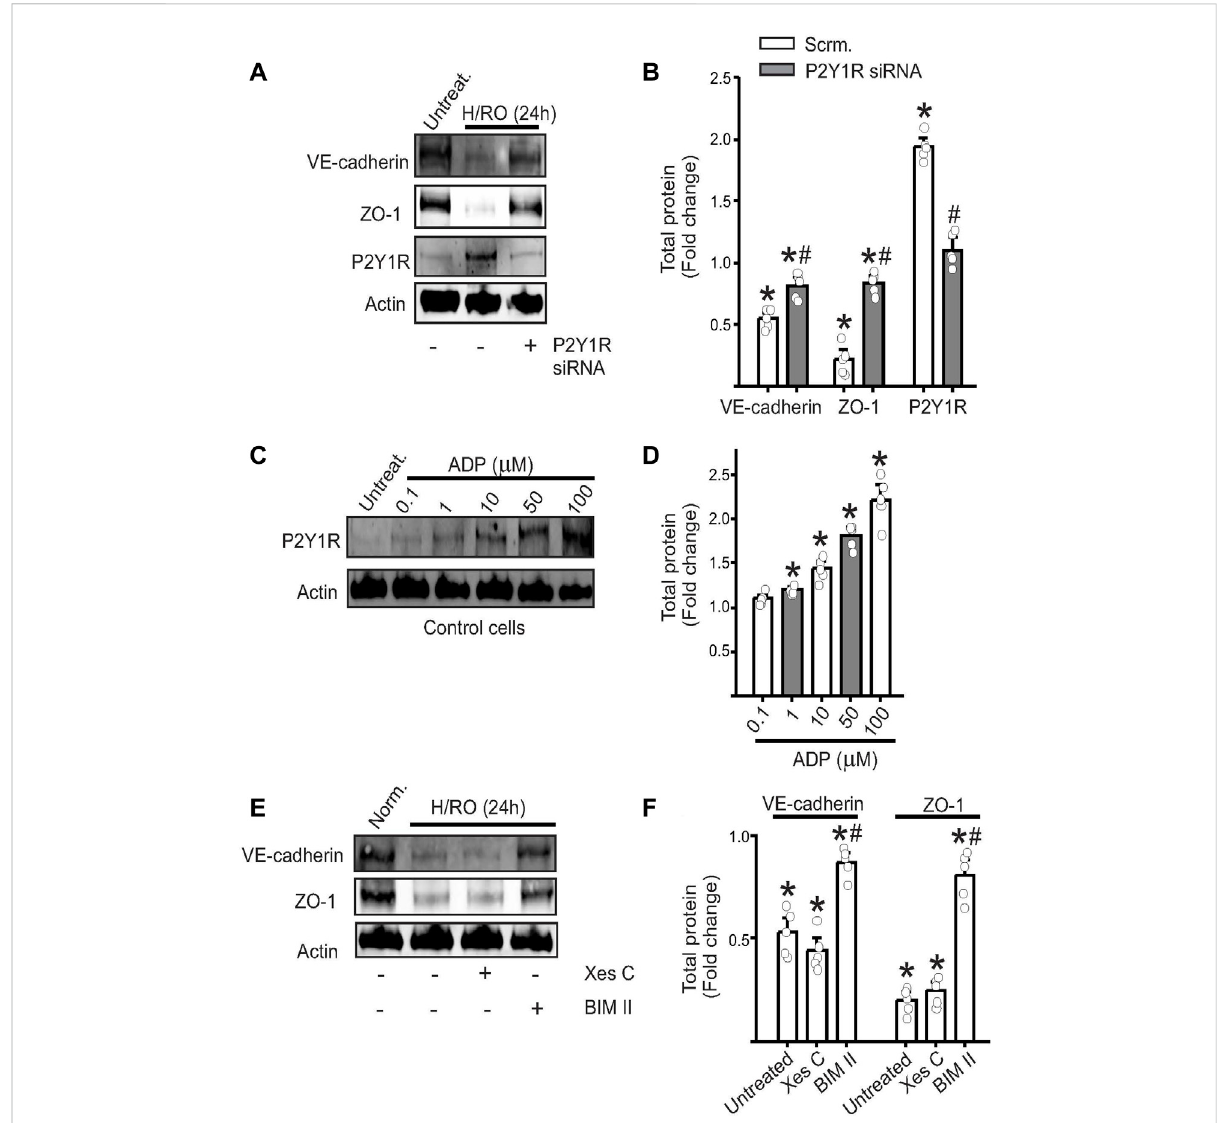
FIGURE 2 P2Y1receptorsignalingdecreasesendothelialjunctionalproteinexpression.RepresentativeWesternblotsfromcontrolcelllysatesshowingthe expressionofVE-cadherin, ZO-1,P2Y1receptorandactinin (A) ,withorwithoutH/ROandP2Y1RsiRNAand (B) ,bargraphforthesameshowingfold change in total protein. Mean ± SE. n = 5 for each, * indicates p < 0.05 vs. normoxic scrambled or no-treatment controls, # indicates p < 0.05 vs. H/ RO (24 h) treatment. (C) Representative Western blots from control cell lysates showing the expression of P2Y1R after addition of ADP to the extracellular media at speci fi c concentrations. (D) Mean data. n = 5 for each, * indicates p < 0.05 vs. untreated controls. (E) Representative Western blots from control cell lysates showing the expression of proteins in control cells with or without H/RO and Xestospongin C (Xes C) or bisindolylmaleimide II (BIM II) treatment. (F) Bar graphs of mean protein expression post-H/RO presented as fold change. n = 5 for each, * indicates p < 0.05 vs. normoxic controls, # indicates p < 0.05 vs. untreated